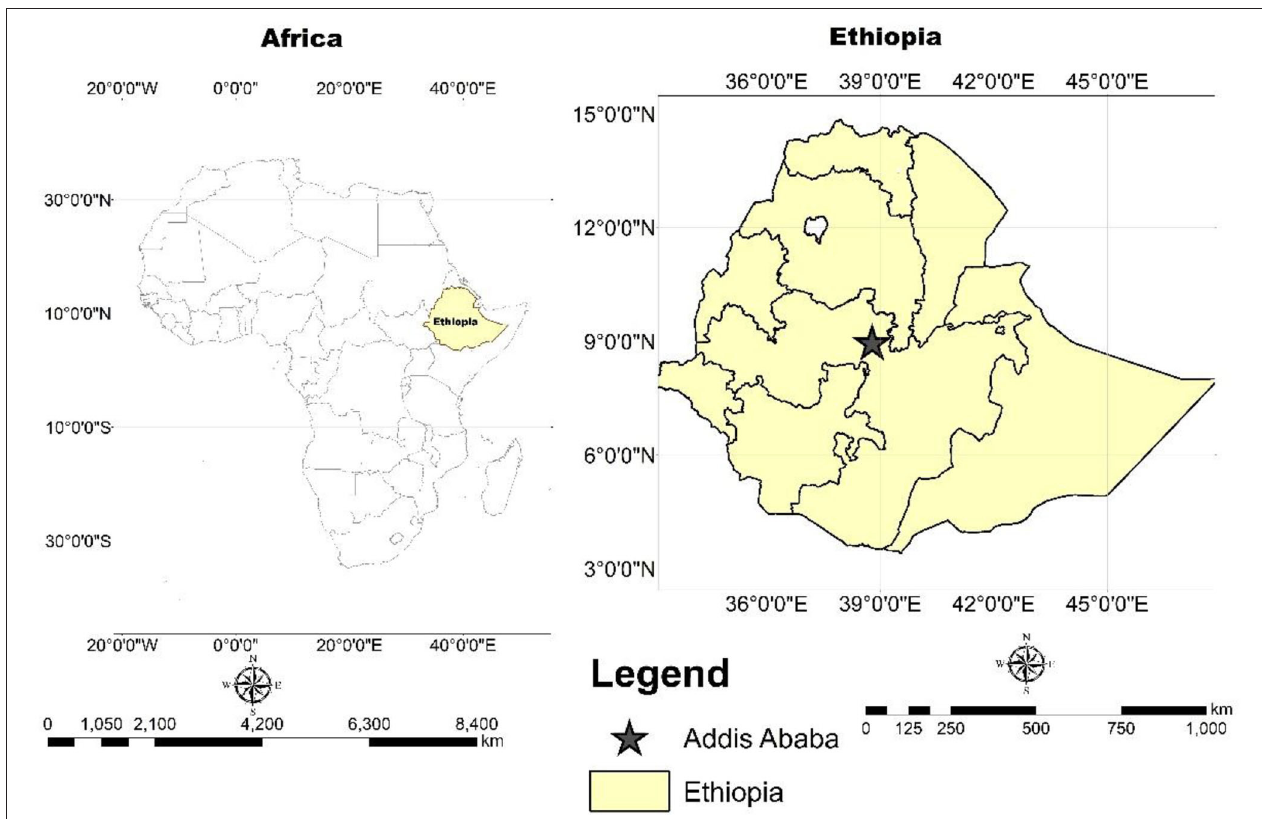
FIGURE 2 | A location map of Ethiopia.